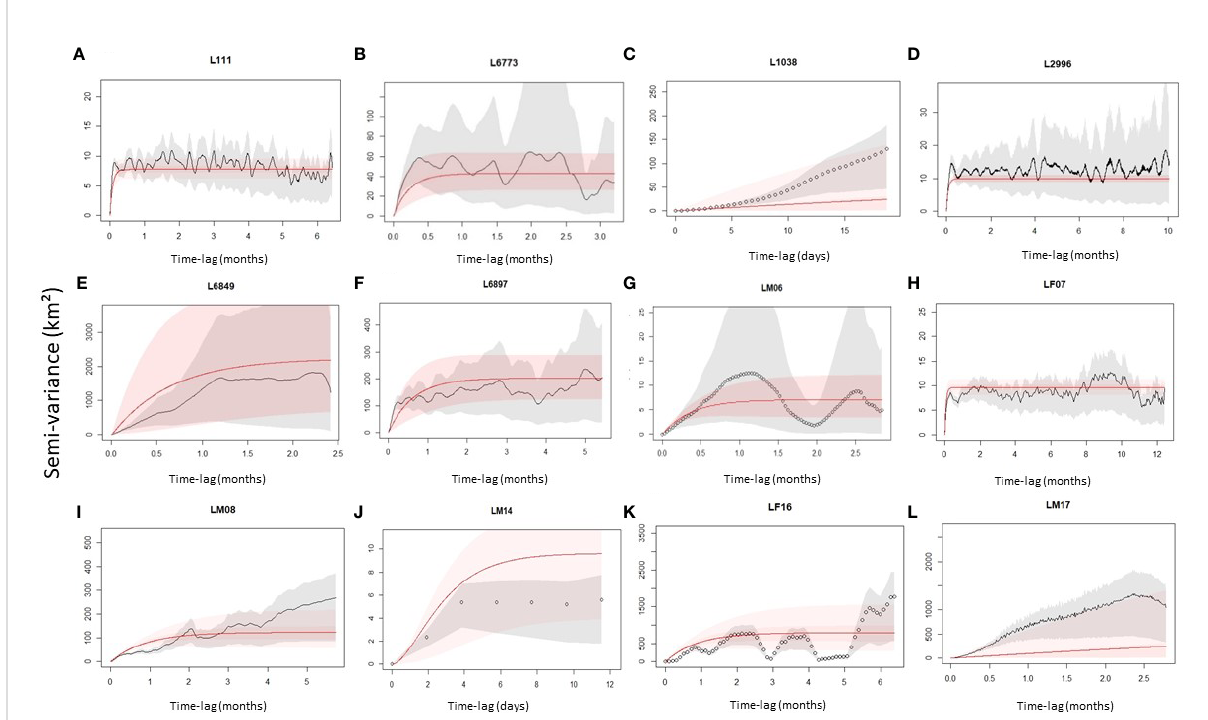
FIGURE 3 Variograms of translocated leopard home range stabilization regimes (A – L) . The gray shading indicates pointwise 95% CI, and the red shading represents fi tted model 95% CI to indicate home range stabilization. Leopards A, B and H home ranges stabilized; however, these were considered relocated individuals moved within their home ranges. Leopards C, E and J indicates non-stabilization. Leopards D, F, G, I, K, and L indicate stabilization at different locations to their original home